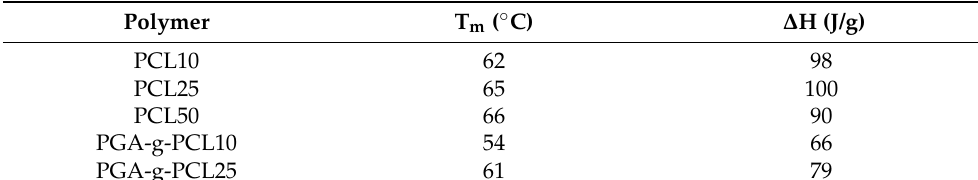
Figure 2. DSC thermograms of the homopolymers PGA ( A ) and PCL10 ( B ).